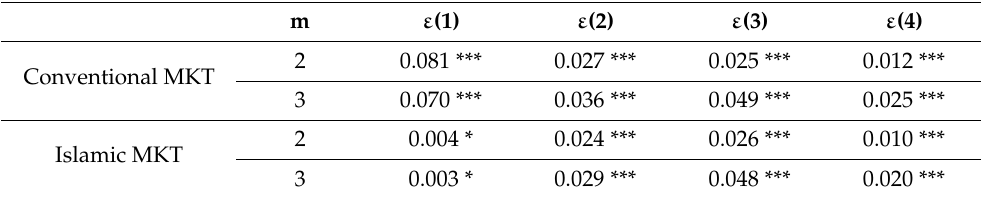
Table 2. Results of BDS test. This Table Report BDS Statistics. “m” Represents Numbers of EMBEDDING